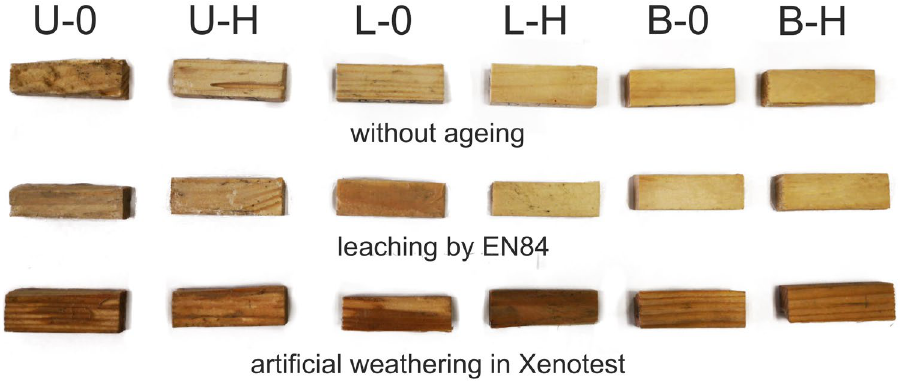
Figure 2. Samples demonstrating termite activity after 6 weeks of testing based on EN 118. Untreated original—(U–O); Untreated, but with the additional hydrophobic substance—(U-H); Treated with the lavender oil—(L-O); Treated with the lavender oil and then with the hydrophobic substance (L-H); Treated with the Bochemit QB—(B-O); Treated with the Bochemit QB and then with the hydrophobic substance—(B-H).